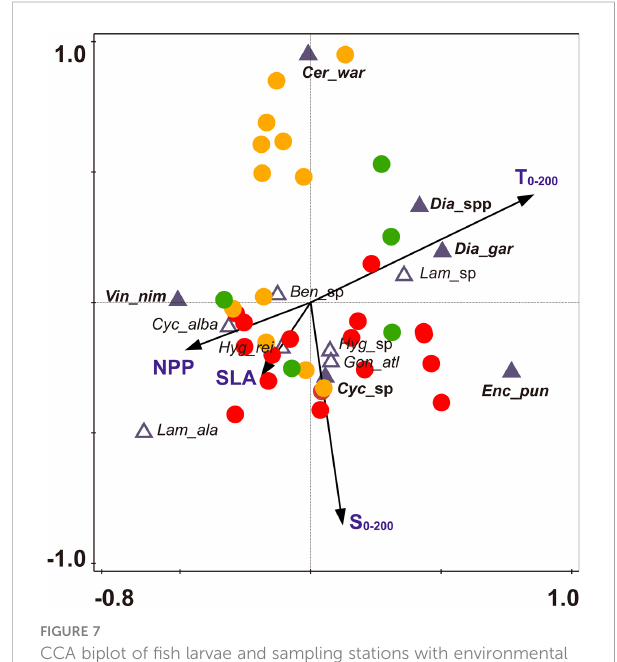
FIGURE 7 CCA biplot of fi sh larvae and sampling stations with environmental factors in the Philippine Sea. The dominant species are shown in a bold and fi lled triangle, Ben_ sp ( Benthosema sp.), Cer_war ( Ceratoscopelus warmingii ), Cyc_abla ( Cyclothone alba ), Cyc_ sp ( Cyclothone sp.), Dia_gar ( Diaphus garmani ), Dia_ spp Diaphus spp.), Enc_pun ( Encrasicholina punctifer ), Gon_atl ( Gonostoma atlanticum ), Hyg_rei ( Hygophum reinhardtii ), Hyg_ sp ( Hygophum sp.), Lam_ala ( Lampanyctus alatus ), Lam_ sp ( Lampanyctus sp.), Vin_nim ( Vinciguerria nimbaria ). Stations sampled in summer are shown in red, stations sampled in autumn are shown in orange, and stations sampled in winter are shown in